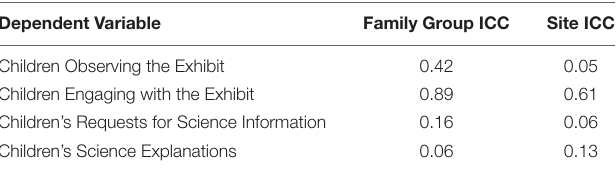
TABLE 3 | Intra-class correlation coefficients accounting for family group and site level variance in key dependent